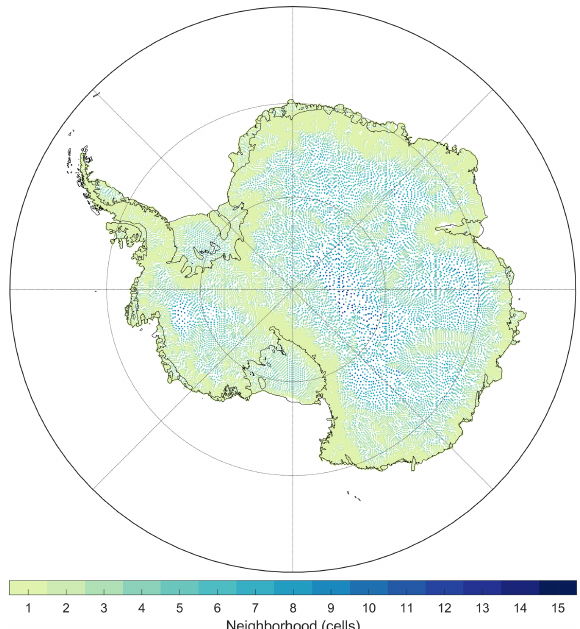
Figure 3. The Antarctic GSFC-FDM simulation locations colored by the representative size of their neighborhood. Darker colors (larger neighborhoods) with more white space (redundant simula- tions) indicate that the gradients in mean annual climate variables do not vary significantly over short length scales. Paler colors sug- gest stronger gradients with fewer redundant